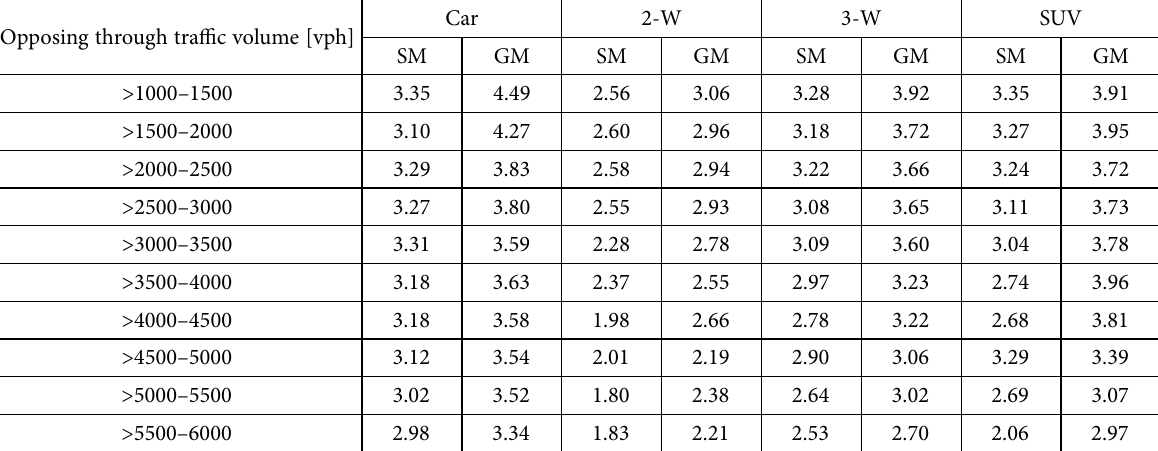
Table 7. The merging statistics for different categories of vehicles Opposing through traffic volume [vph]